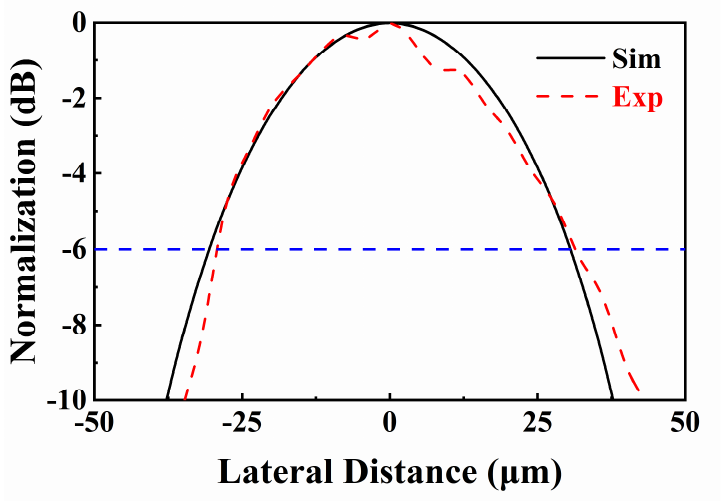
Figure 8. Comparison of the amplitude of simulation and experimental data for lateral line spread function.